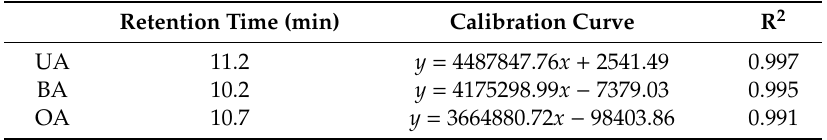
Table 1. Calibration curves of the three triterpenic acids studied, and the respective retention times (min) and the coe ffi cients of correlation (R 2